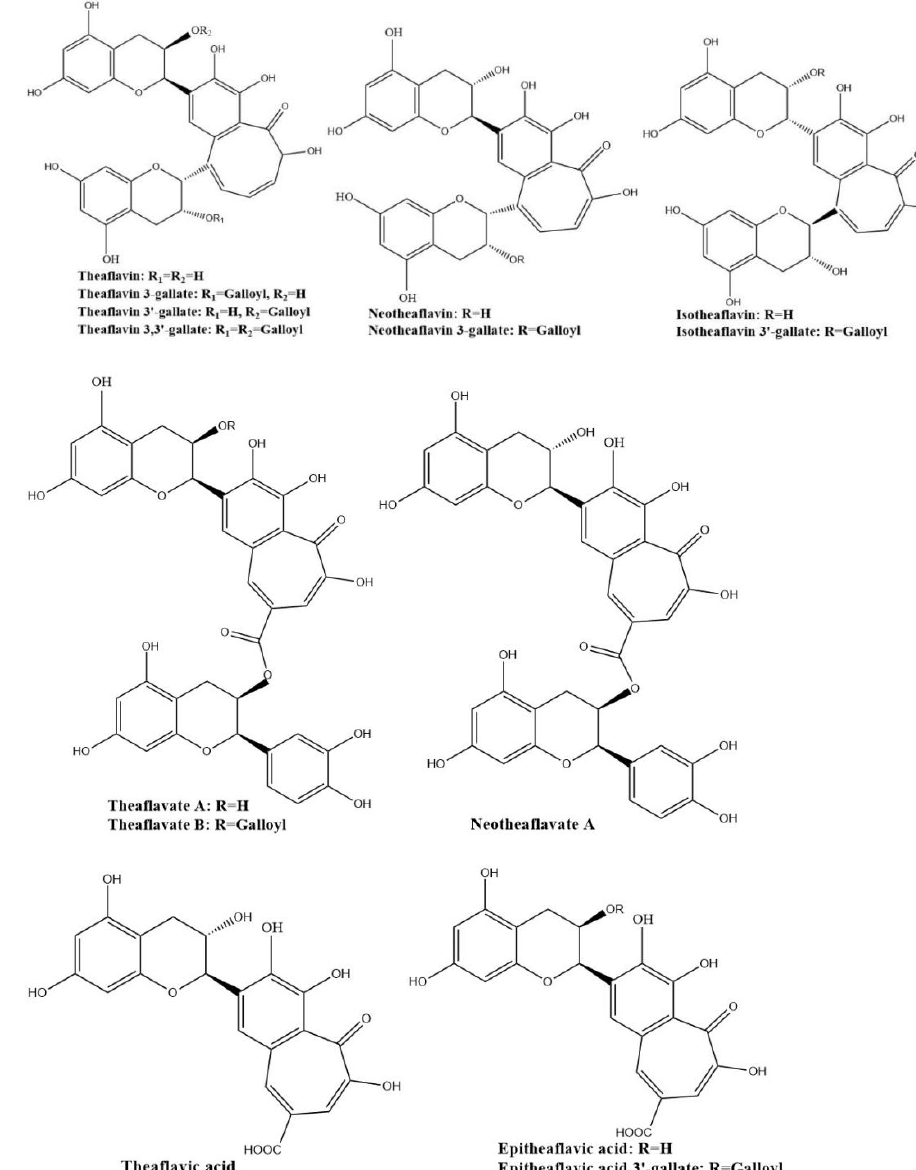
Figure 4. Structures of the major theaflavin derivates in black